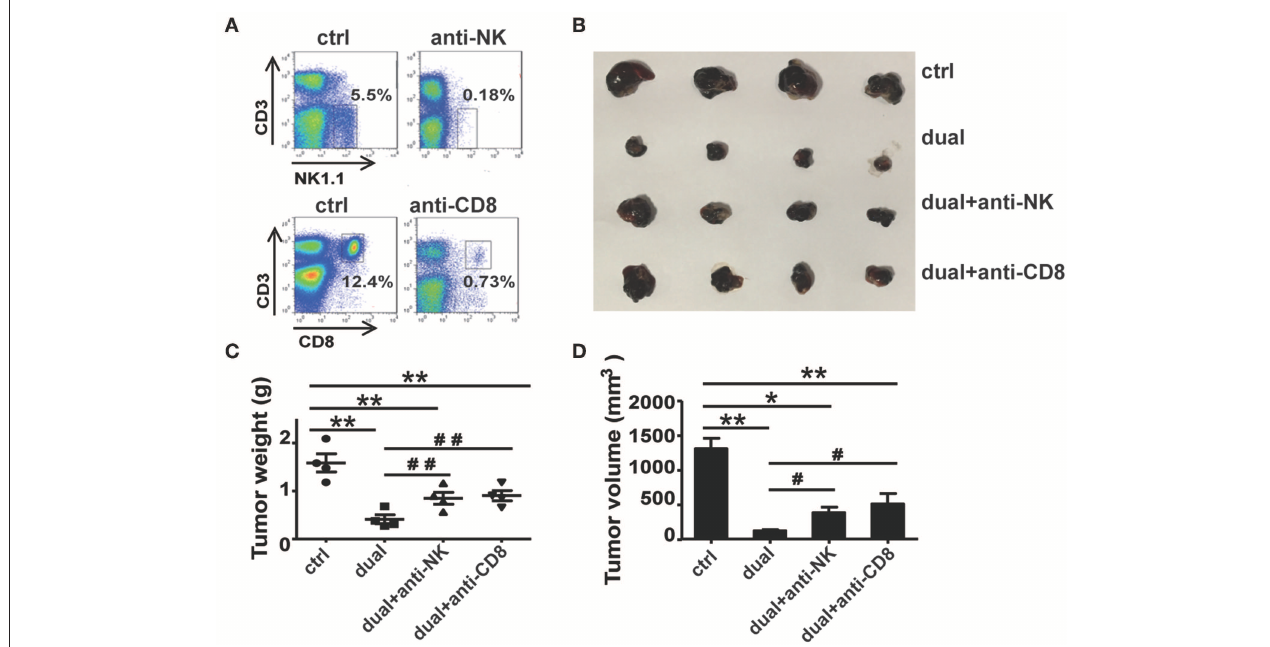
FIGURE 4 | NK and CD8 + T cells are necessary for the treatment effect of the dual-function vector on B16F10 melanoma. (A) The effect of PK136 and 2.43 antibodies on NK and CD8 + T cell depletion. (B) Tumor sizes after treatment. (C) Analysis of tumor weights. (D) Analysis of tumor volumes. Data are representative of three independent experiments. ** P < 0.01 or * P < 0.05 vs. control group. # P < 0.05 and ## P < 0.01 vs. dual group. NK, natural